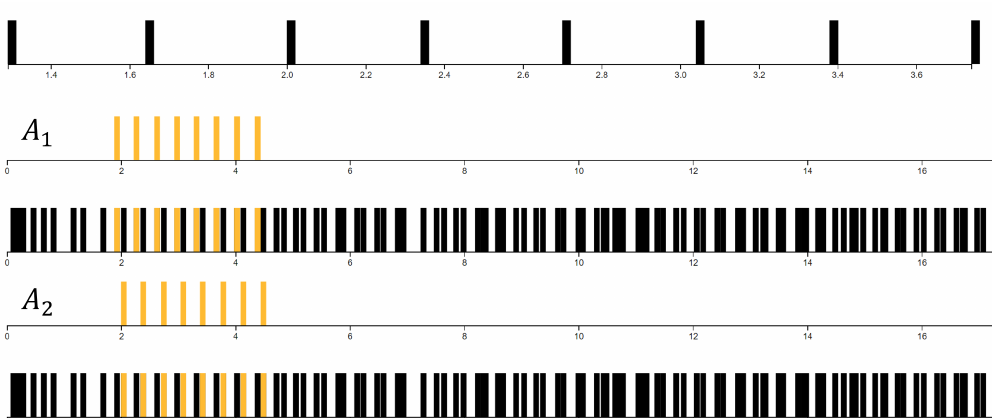
Figure 11. The L 5 part representing a straight rhythm. Below the part’s structure, two typical activations are depicted individually with their projections onto the input layer. The first activation covers eight consecutive downbeats, whereas the second activation covers the syncopation of the swing rhythm in the input, imitating straight rhythm with shifted phase.